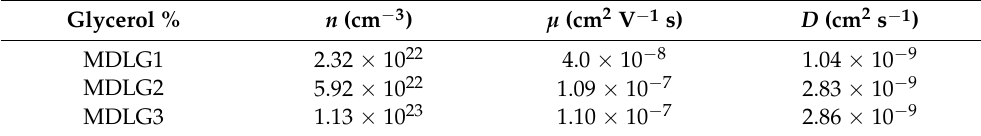
Table 2. The n , D , and µ at ambient temperature from FTIR